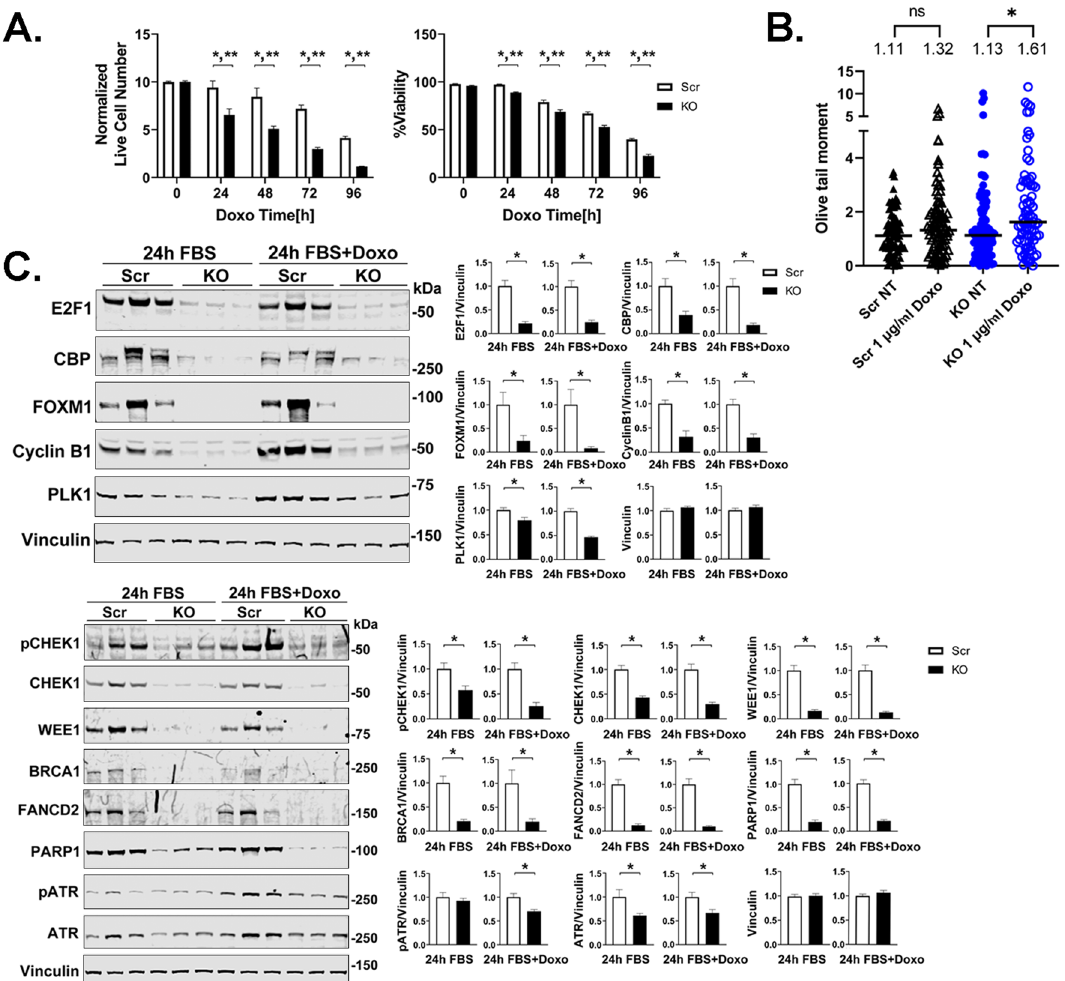
Figure 7. Deletion of TRPM2 in U937 cells. ( A ) TRPM2 KO and Scr U937 cells were plated at time 0, and live cell number and viability (% live cells/total × 100%) measured at 0 to 96 h after treatment with 0.1 µM doxorubicin (n = 7–12/group). Means ± S.E.M. are shown. Statistics: two-way ANOVA, *p < 0.0001, indicates significant differences between Scr vs KO, Group Effect; **p < 0.003 group x doxorubicin exposure time interaction effect (indicates the differences between groups significantly increased with time of doxorubicin exposure). ( B ) DNA damage was quantitated with neutral Comet Assay. Scr (triangles) and KO (circles) U937 cells were studied without treatment (NT), or 24 h following treatment with 1 µg/ml doxorubicin. Open triangles (Scr) and open circles (KO) indicate treatment with doxorubicin. Two experiments were performed with similar results and one is shown. Tails (n = 77–93 /group) were analyzed for differences between no treatment and doxorubicin treatment. Figure was prepared using the CometScore 2.0 softwear. Statistics: two-tailed Mann–Whitney test, *p < 0.05. ( C ) Western blots using lysates from three clones of TRPM2 KO or scrambled control cells were probed with antibodies to cell cycle proteins E2F1, CBP, FOXM1, Cyclin B1, and PLK1 or DNA damage response proteins pCHEK1, CHEK1, WEE1, BRCA1, FANCD2, PARP1, pATR, and ATR. Samples (Scr, KO) were derived from the same experiment and were always processed in parallel. One Western blot for each antibody is shown. Each blot was probed with anti-vinculin antibody as control. The different probes for each antibody are made explicit with white space and each antibody probe is delineated with a black box. Densitometry measurements for three experiments were normalized to vinculin and each blots’ Scr control, and mean ± S.E.M. for each protein from the three (n = 9) is shown. Statistics: unpaired, two tailed t test, *p < 0.02. Full length gels for Western blots are shown in Supplementary Fig.